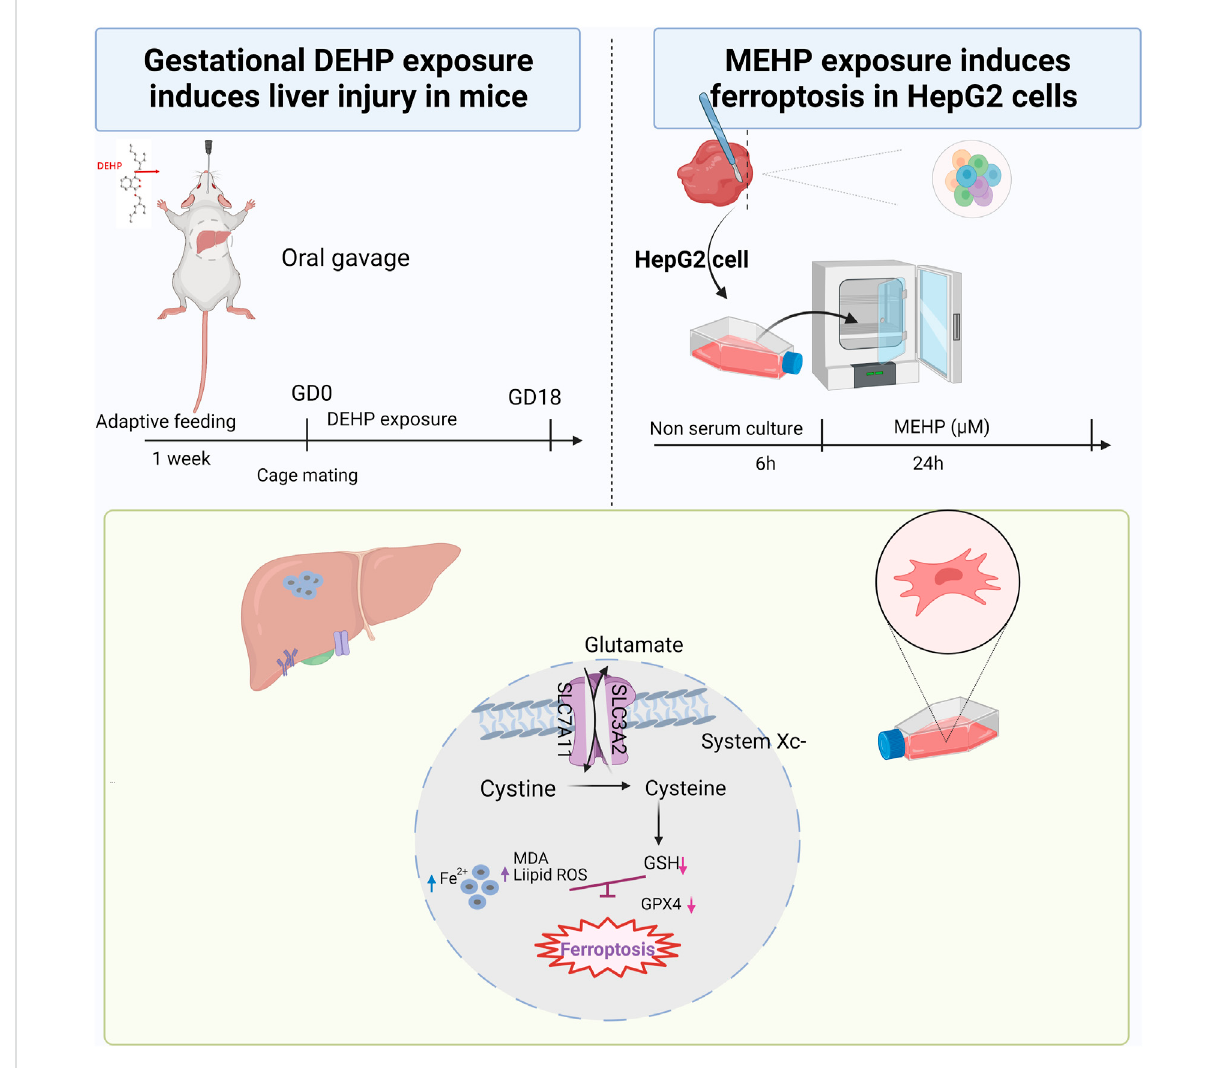
FIGURE 7 Summary of the experiment conducted in mice and HepG2 cells and the proposed pathway of DEHP-induced liver injury. DEHP or MEHP exposure induces ferroptosis by promoting iron metabolism, accelerating GPX4 proteasomal degradation and inducing excessive oxidative stress in hepatic cells. The fi gure was partly generated using Bio-Render, and con fi rmation of publication and licensing rights was provided by Bio-Render.